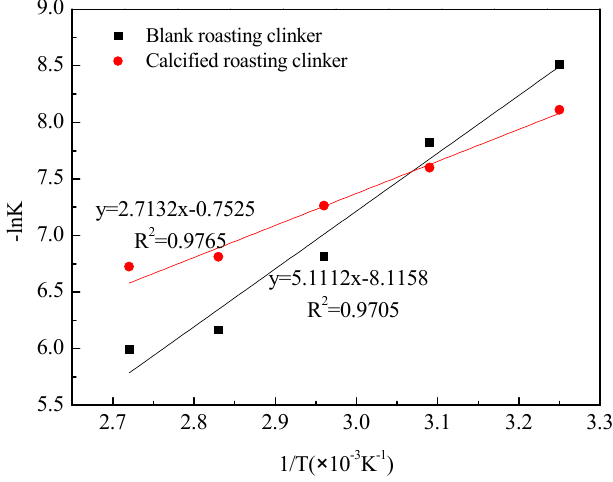
Figure 12. The fitting curve of roasted clinker − lnk and 1/T.